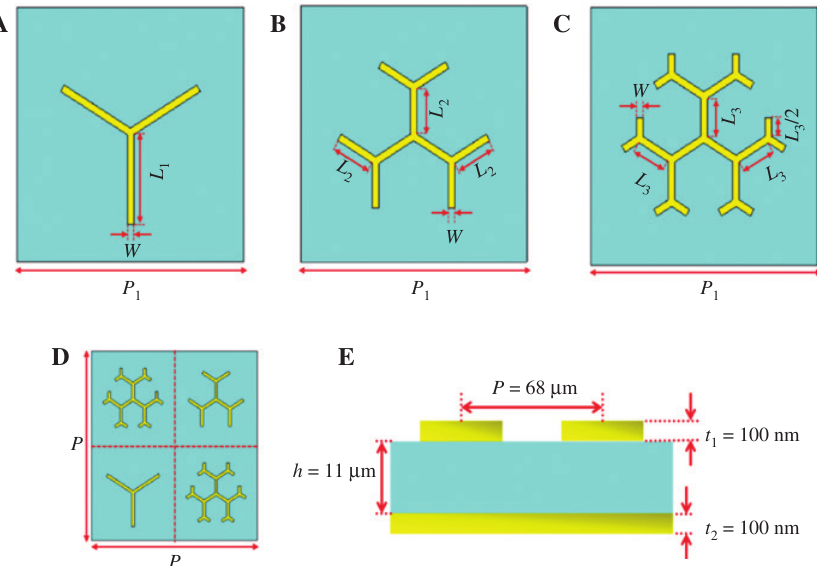
Figure 1: Fractal broadband absorbers. (A) Fractal level 1, (B) fractal level 2, (C) fractal level 3. (D) Supercell arrangement obtained by combining all three fractal orders. (E) Side view of supercell design. The arm length of level 1 is L is L /2. The arm width w = 1 μ m. The period of supercell is P = 68 μ 3